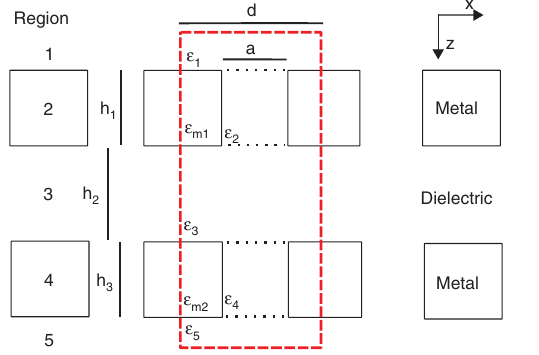
Figure 1: Unit cell representation of the periodic MIM structure. The dashed rectangle represents the structure with periodicity d ; slit width a ; and thicknesses h